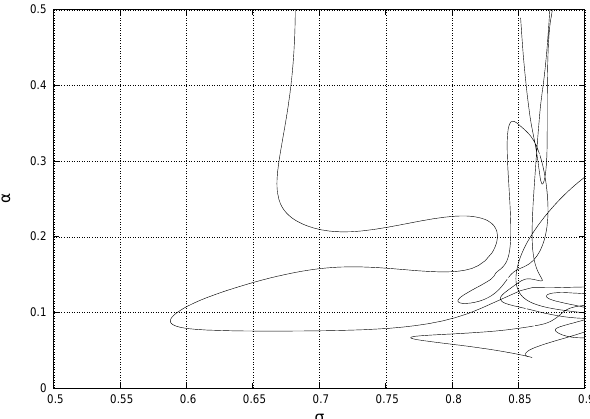
Fig.10: Positionofthepitchforkbifurcationsinthe ( σ,α ) plane. The‘S’-shapedcurveisassociated Fig. 10. Position of the pitchfork bifurcations in the (σ,α) plane. with the pitchfork bifurcations described in the previous subsections. The S-shaped curve is associated with the pitchfork bifurcations de- scribed in the previous